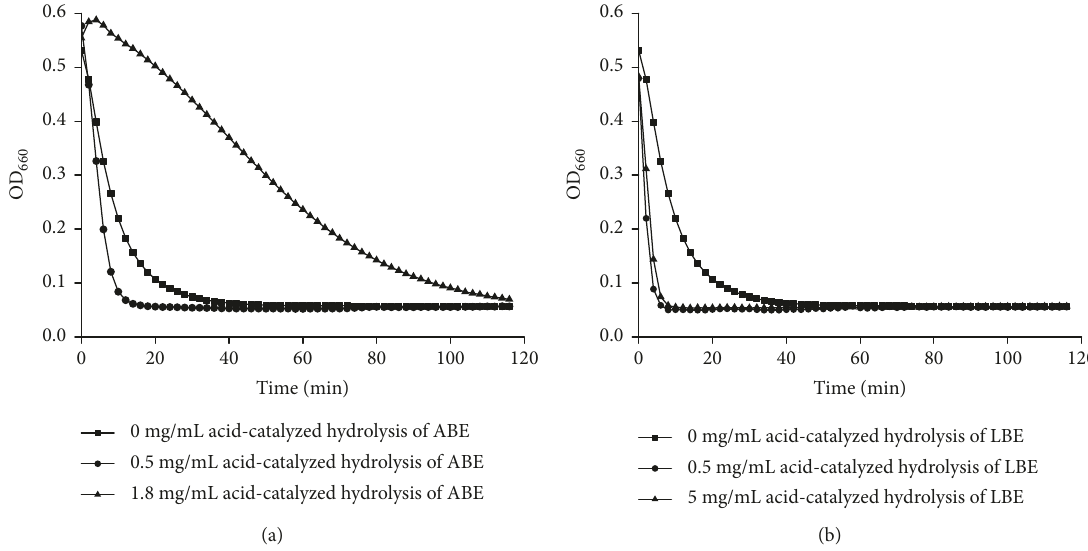
one standard deviation. ±